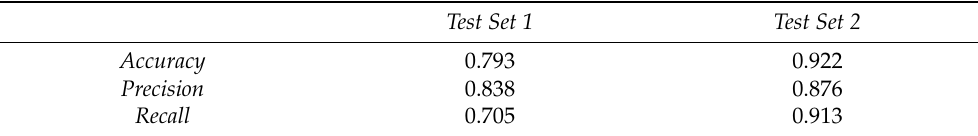
Table 4. Results of the CNN model’s prediction when compared with SAS data.